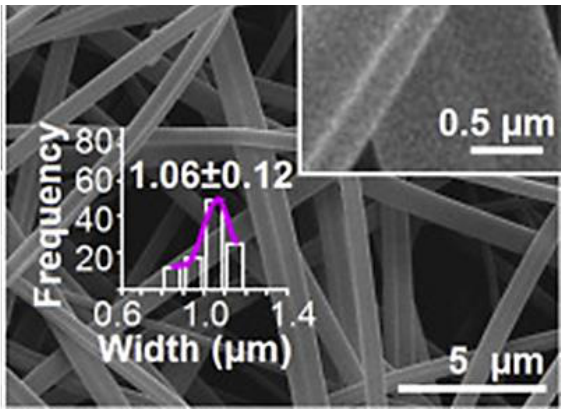
Figure 13. Fibres prepared from side-by-side electrospinning one side composed of PVP while the other side composed of EC, doped with small amount of PVP. Reproduced with permission from [130], copyright 2016 Elsevier. Table 5. Summarised characteristics some studies employing side-by-side electrospinning for drug delivery applications.